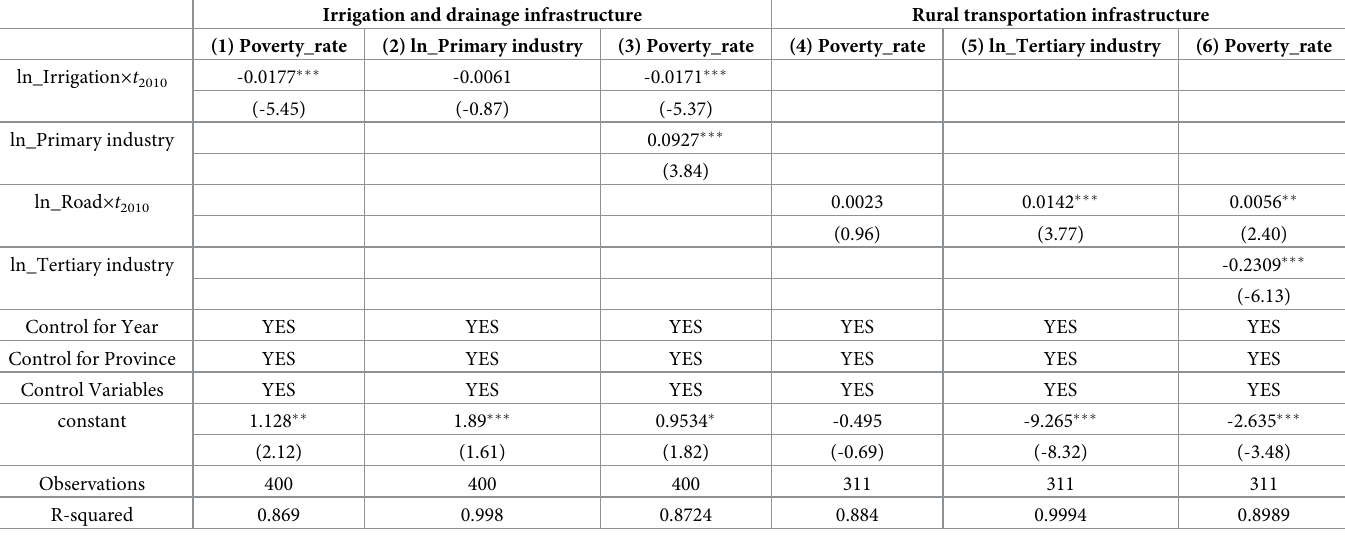
Table 8. Result of mediating